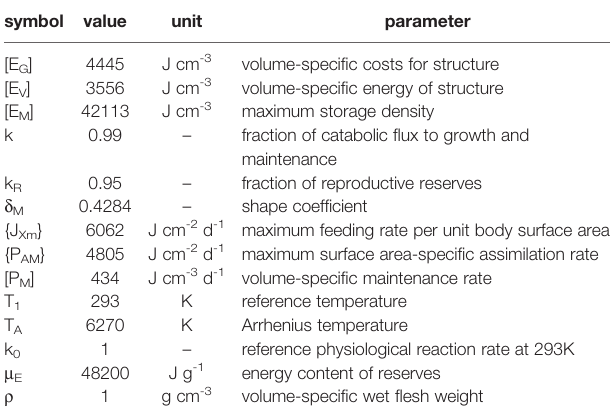
TABLE 3 | The parameter values of the DEB model for swimming crab Portunus trituberculatus at